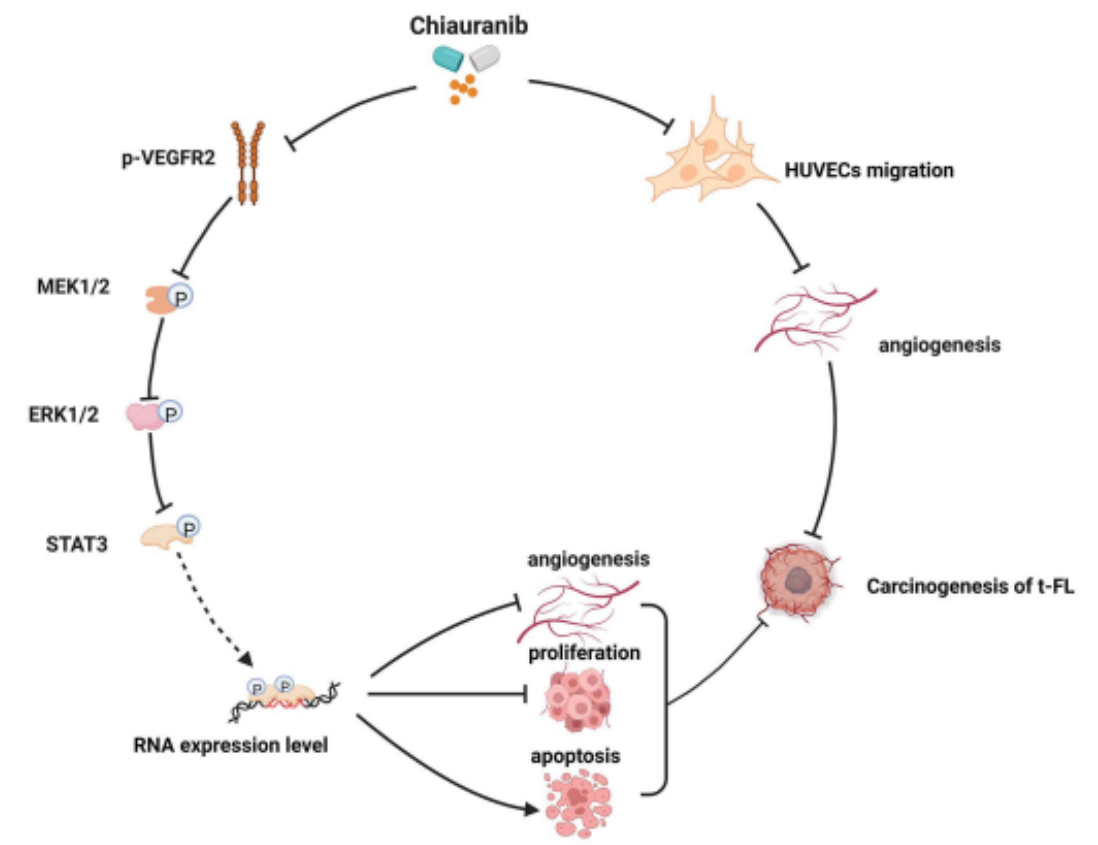
Figure 8. Schematic diagram of the mechanism by which chiauranib acts on t-FL.